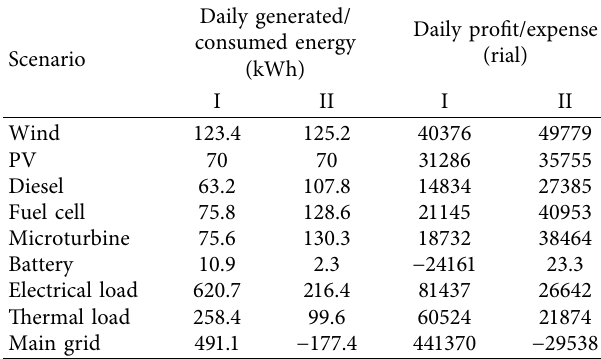
Table 3: Te average results of EMS based on [21] over 800days. Daily Scenario